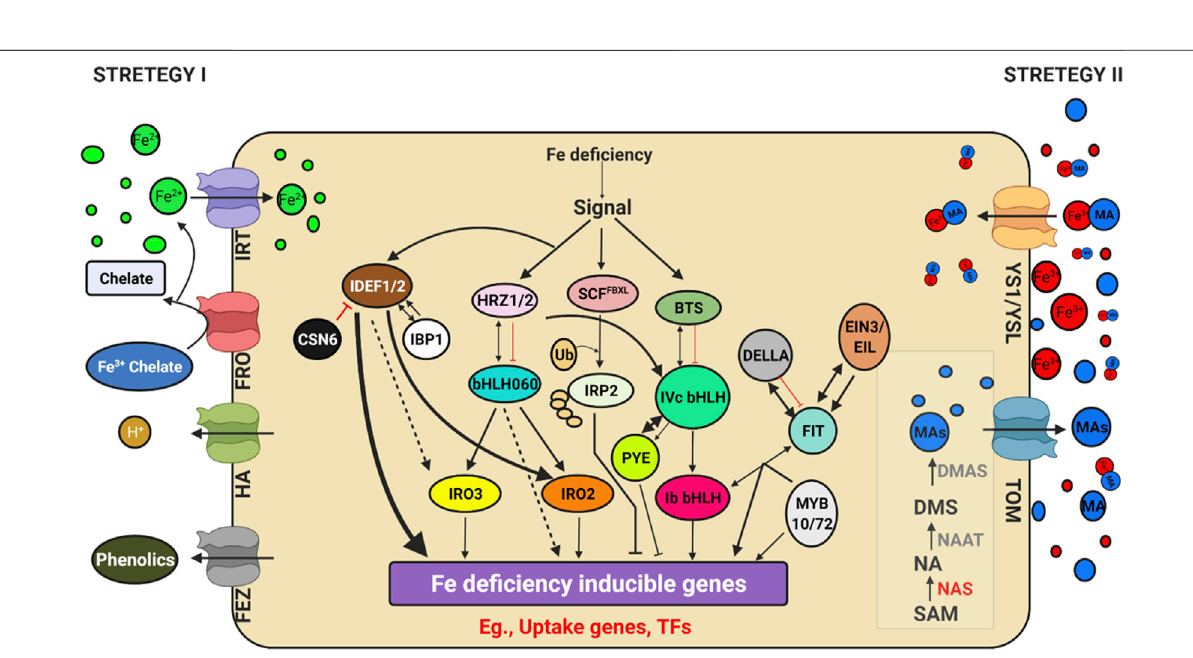
Frontiers in Genetics |